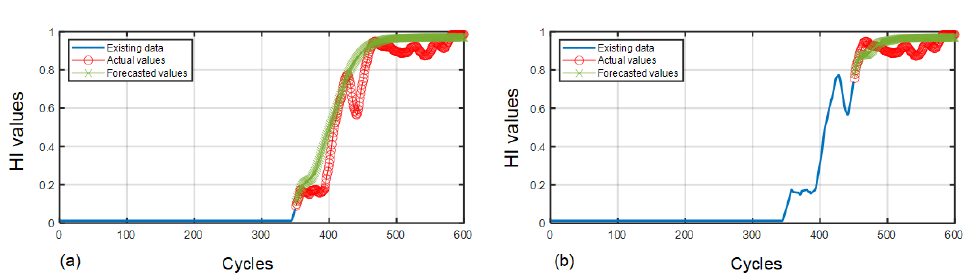
Figure 14. LSTM-RNN-based RLU prediction results of concrete beam A: ( a ) at cycle 350; ( b ) at cycle 450.